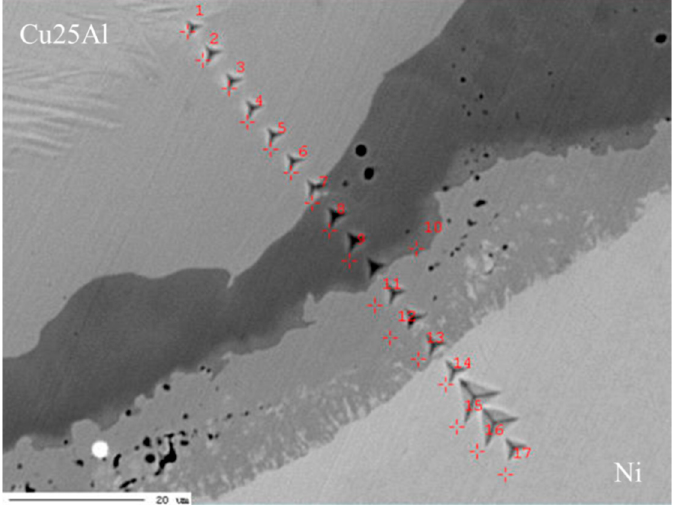
Figure 3. The nanoindentations of the Cu25Al–Ni interface diffusion zone, 650 °C × 400 h.